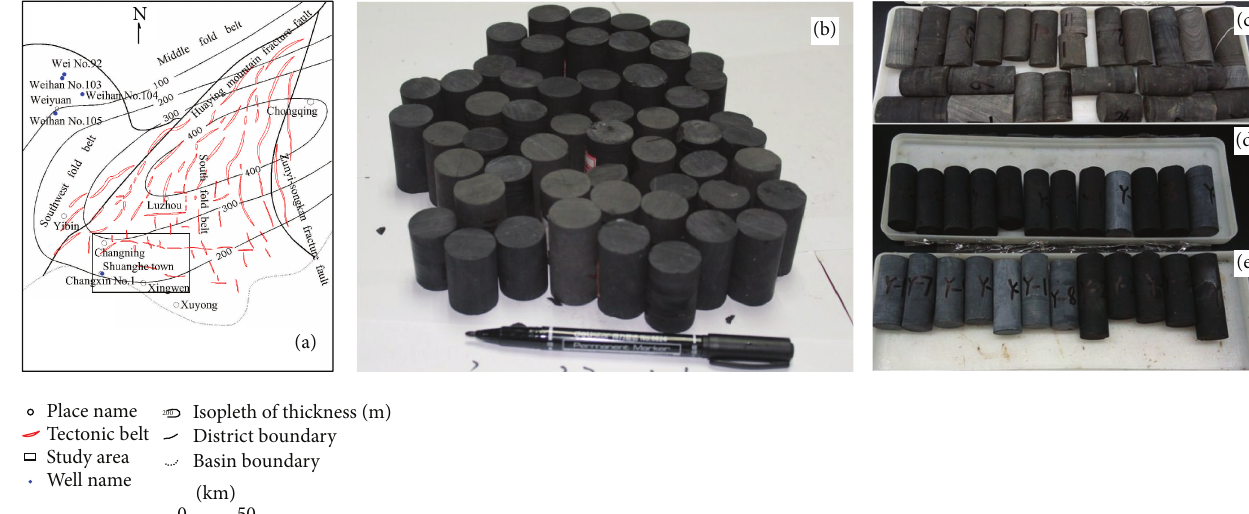
Figure 1: Information on shale specimen: (a) tectonic map, (b) shale specimen, (c) specimens with different bedding angles, (d) specimens with different porosities, and (e) specimens with different ratios of height/diameter